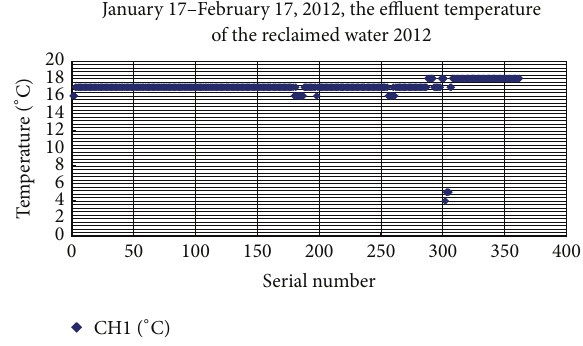
Figure 1: Water outlet temperature in the winter of 2012, January 17–February